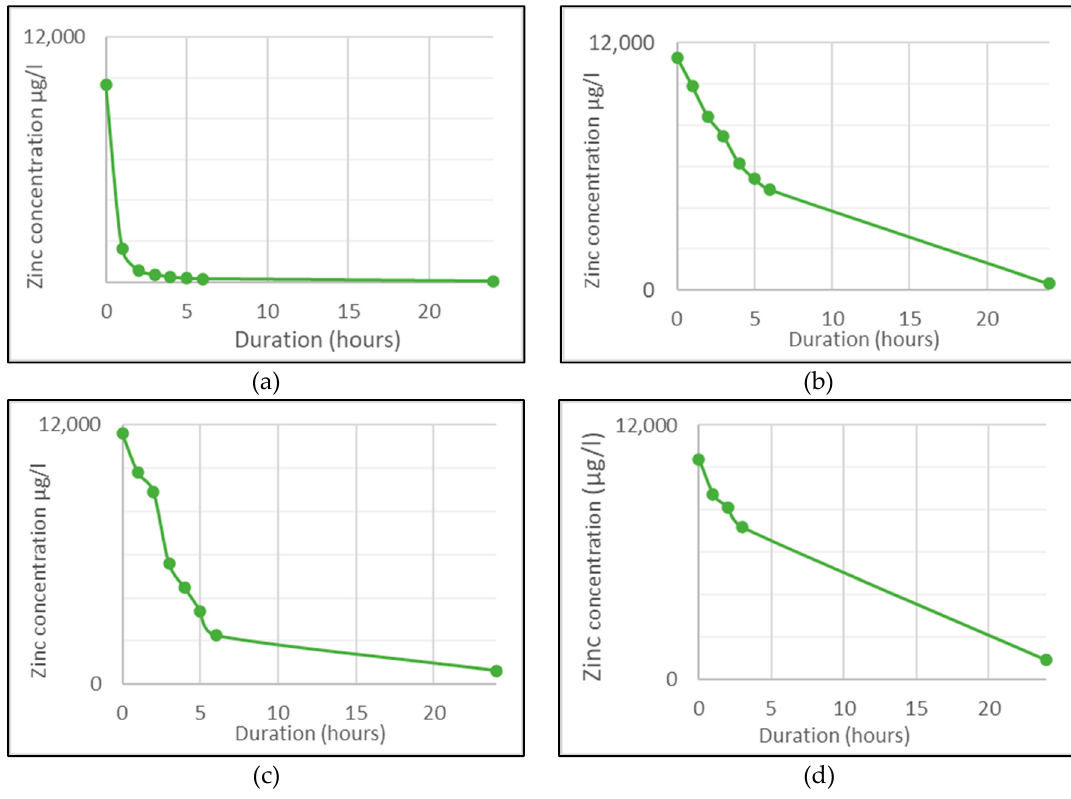
Figure 3. Zinc concentrations over a 24 h period influenced by the different pellets. ( a ) Compressed pellets (CP), ( b ) fired acid etched pellets (FAE), ( c ) powdered pellets (PP), ( d ) fired pellets (FP). Table 1. PH changes in the mine adit water using the di ff erent types of pellet. Raw data extracted from Turner (2017) [21] and Hill (2016) [19].